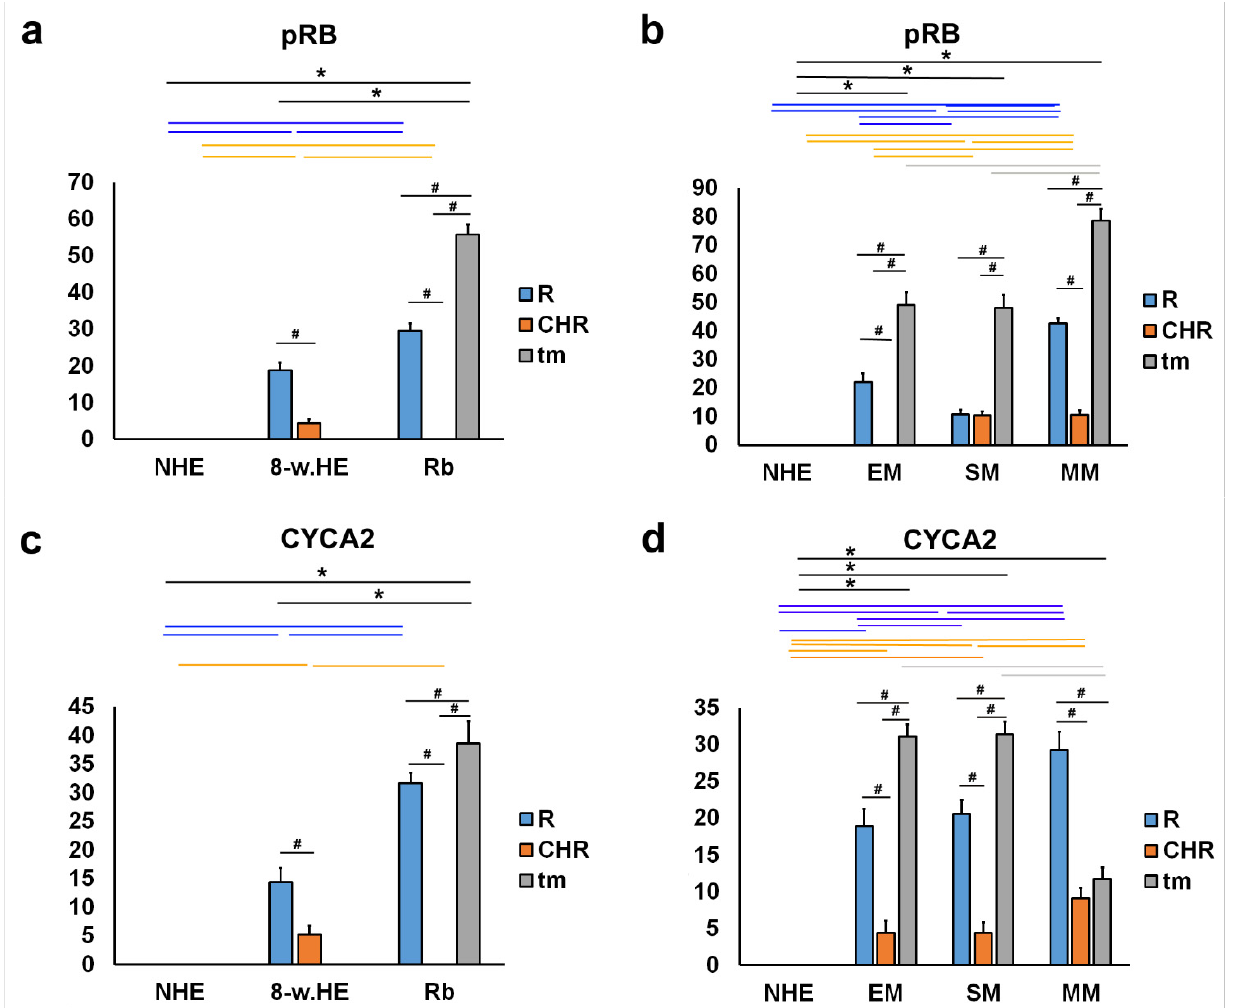
Figure 7. Quantitative analysis of pRB and CYC7A2 expression. The threshold area percentage of pRB and CYC7A2 in the normal human eye (NHE), the eye section of an 8-week human embryo (8-w.HE), retinoblastoma (Rb), epithelioid melanoma (EM), spindle melanoma (SM), and myxoid melanoma (MM). Data are shown as mean ± SD. #—statistically significant differences (comparison between retina, choroid and tumor of the same specimens); blue line—statistically significant differences-comparison of the retina between NHE, 8-w.HE, tumor and different type of melanomas); grey line—statistically significant differences-comparison of the tumor tissue between different type of melanomas; *—statistically significant differences (comparison between Rb and retina or melanoma and choroid) (ANOVA and Tukey post-hoc test). All significant differences are presented in Supplementary Tables S11–S14.